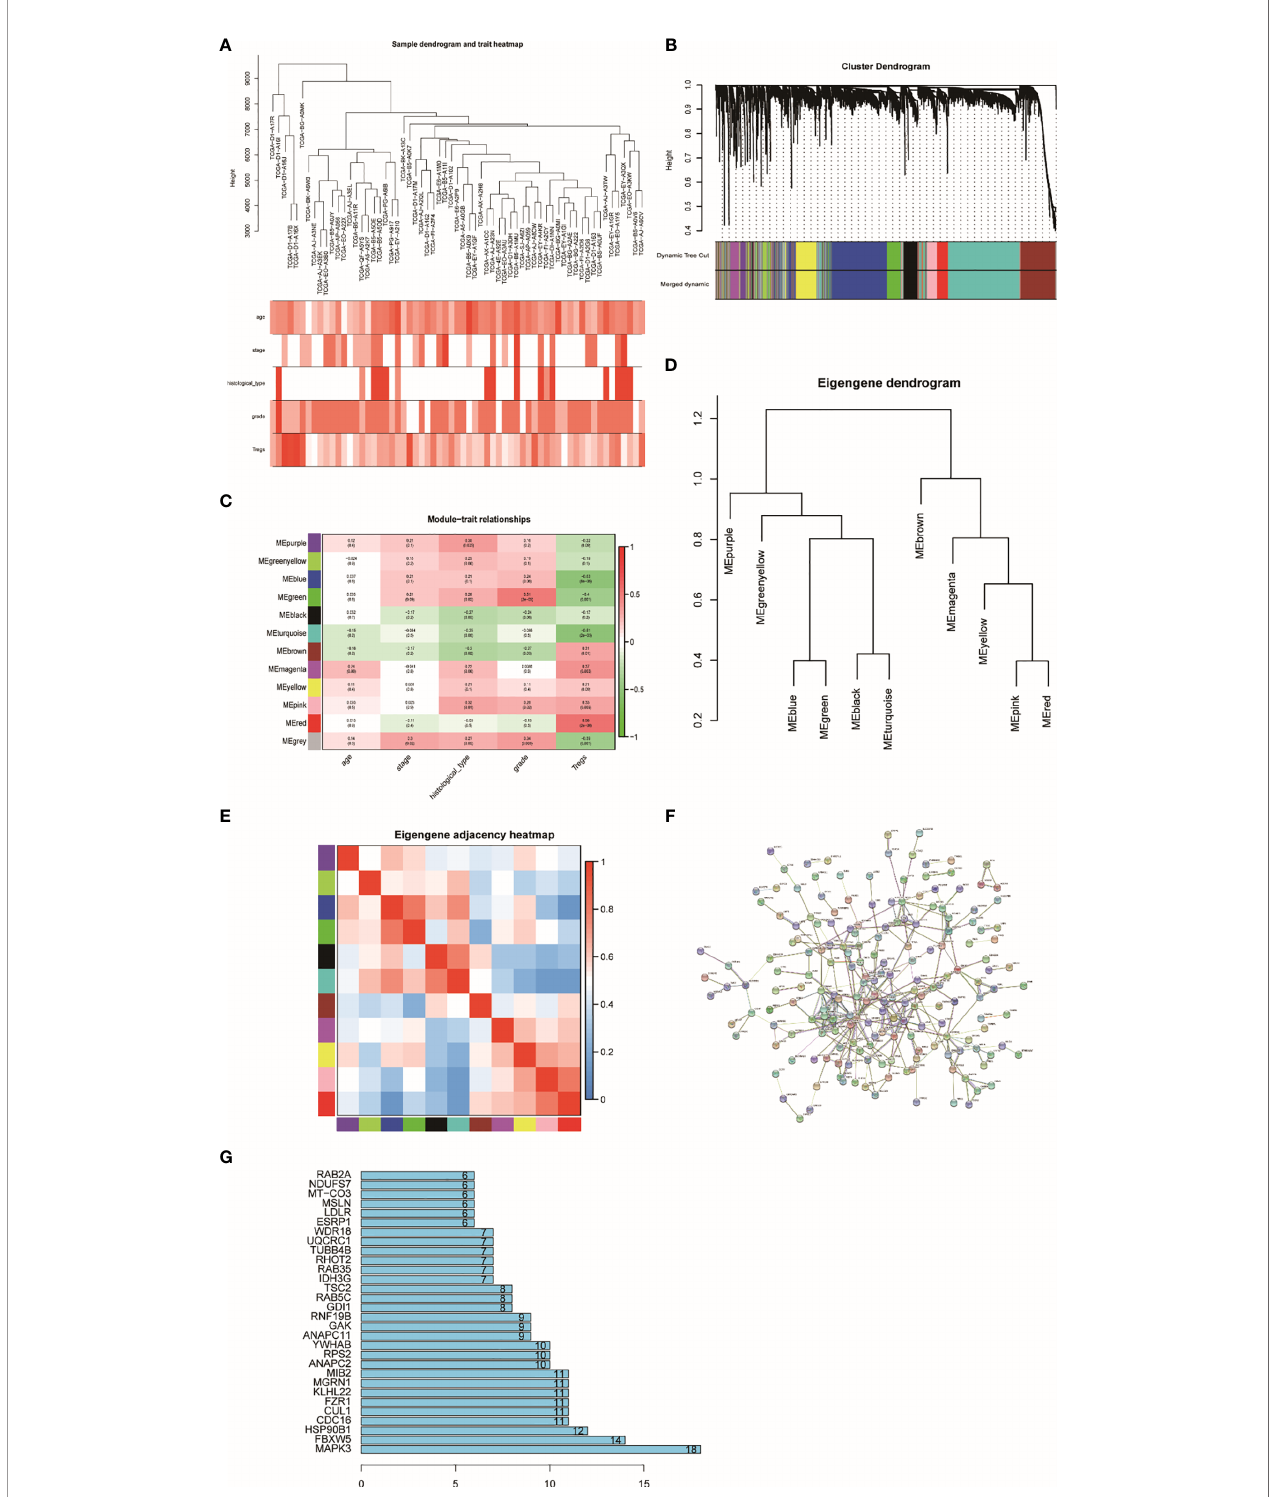
FIGURE 2 | Sample clustering and correlation analysis. (A) Sample dendrogram and trait indicator: in the heat map, the darker the color, the stronger the correlation between samples and clinical traits. (B) Clustering dendrogram of 4,703 genes with difference in Tregs and 12 gene modules from 298 UCEC. (C) Heatmap of the correlation between module eigengenes and clinical characteristics of UCEC. (D) Randomly selected partial genes to make network heatmap plot. (E) Eigengene dendrogram and adjacent heatmap. (F) PPI network constructed using STRING. (G) Bar graph of the top 30 genes that have more connections with other